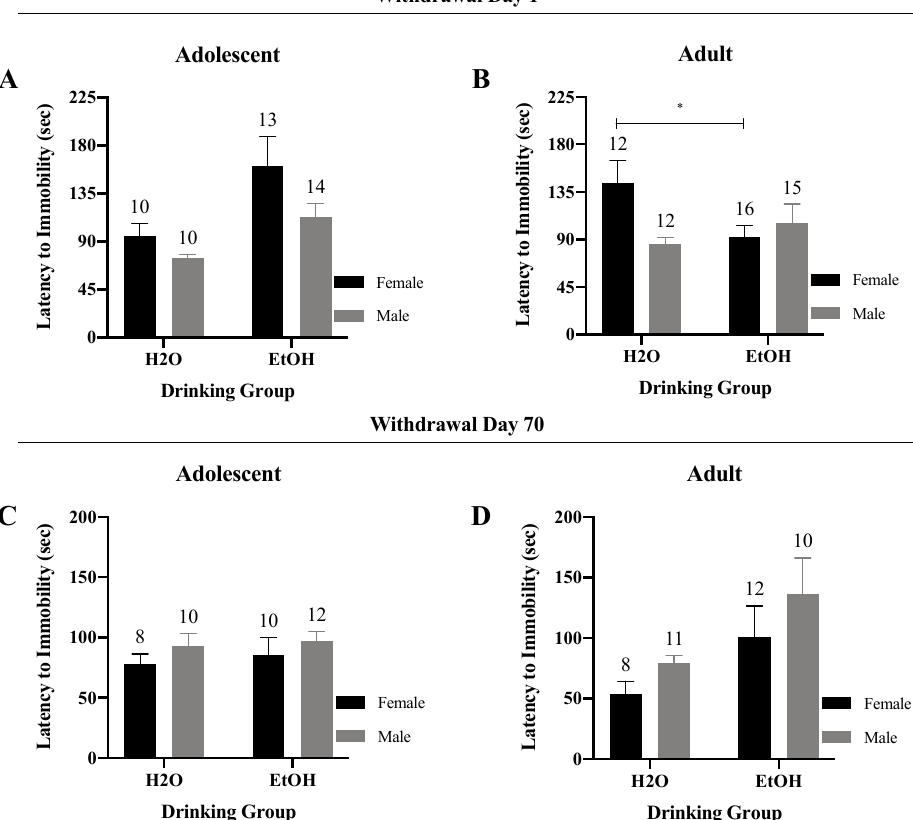
Figure 9. Summary of the results for the Sex × Drinking ANOVA observed for the latency to immobility in the Porsolt Forced Swim Test. ( A ) Depiction of the results for the adolescent-onset mice at 1-day withdrawal. ( B ) Depiction of the Sex × Drinking interaction detected for the female adult-onset mice at 1-day withdrawal. ( C ) Depiction of the results for the adolescent-onset mice at 70-days withdrawal. ( D ) Depiction of the results for the adult-onset mice at 70-days withdrawal. The data represent the means ± SEMs for the numbers of mice indicated in each panel. * p < 0.05 for female H2O vs. female EtOH.